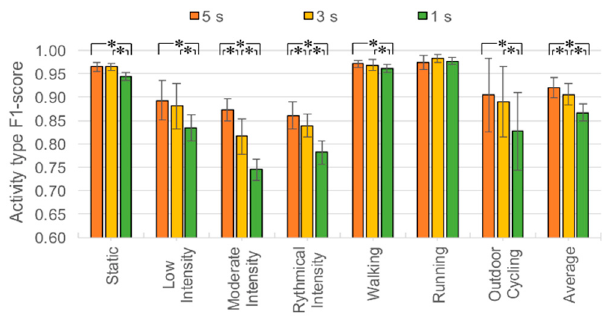
Figure 4. F1-scores of different activity types (mean ± SD (Standard deviation)) averaged over sampling frequencies and feature sets using different window lengths. Asterisks show significant statistical difference between different values of the window length ( p < 0.05).